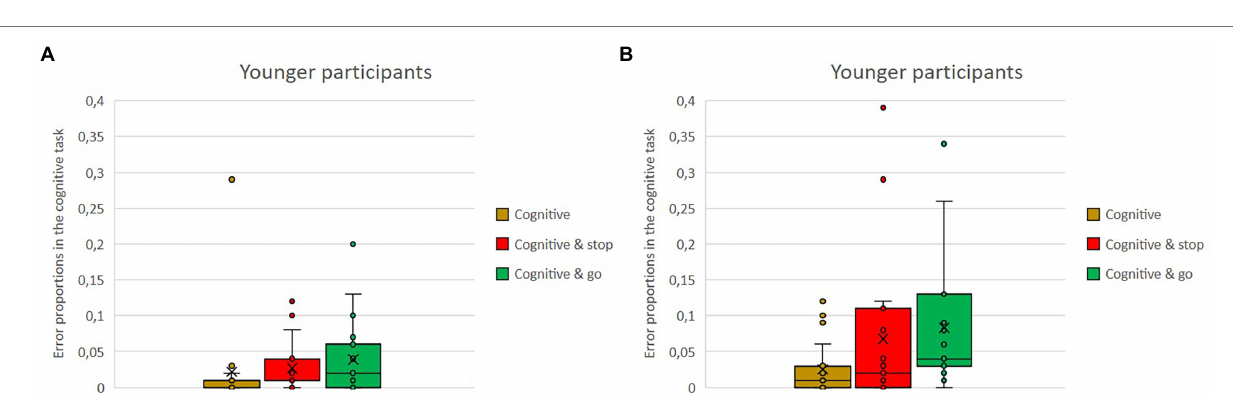
FIGURE 9 | (A,B) Means of error proportion in the cognitive secondary task, as single vs. dual-task conditions with either the stop or the go task for the older and the younger group.